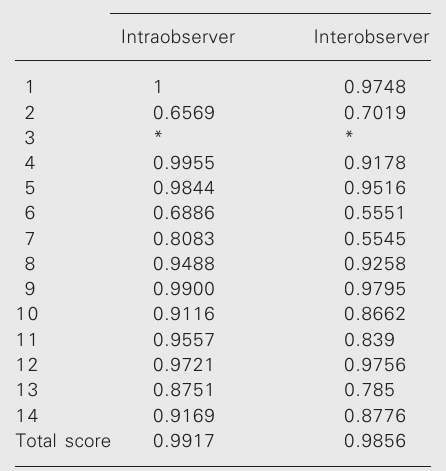
Table 2. Intra- and interobserver reliability ob- tained for each item and for the total score of the Brazilian version of the Berg balance scale as determined by the intraclass correlation coeffi-